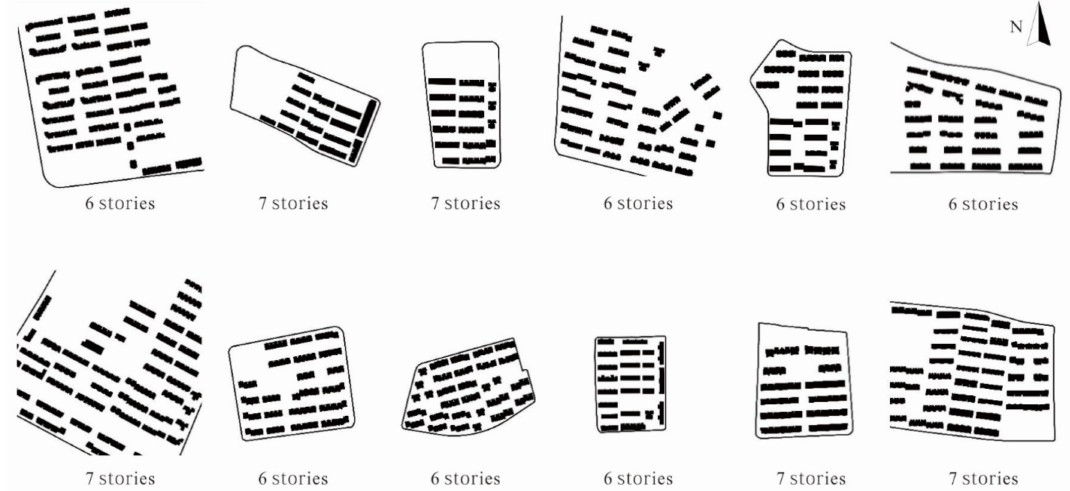
Figure 3. The layout of buildings (morphology) of typical residential districts in Nanjing,